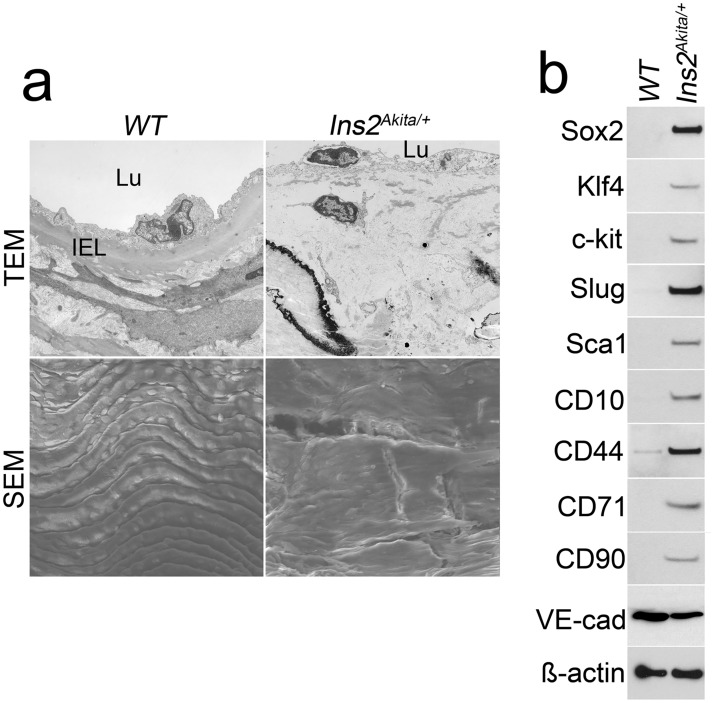
EndMTs in aortic tissue of Ins2Akita/+ mice.(a) Aortic endothelium in Ins2Akita/+ mice was examined by transmission electron microscopy (TEM) (top) and scanning electron microscopy (SEM) (bottom). Magnification for TEM, 3.7×103. Magnification for SEM, 5×102. Lu: lumen; IEL: Internal elastic lamina. (b) Expression of mesenchymal stem cell markers and EC marker VE-cadherin (VE-Cad) in CD31-positive and CD45-negative presorted cells from wild type (WT) and Ins2Akita/+ aortas at 40 weeks of age, as determined by immunoblotting.